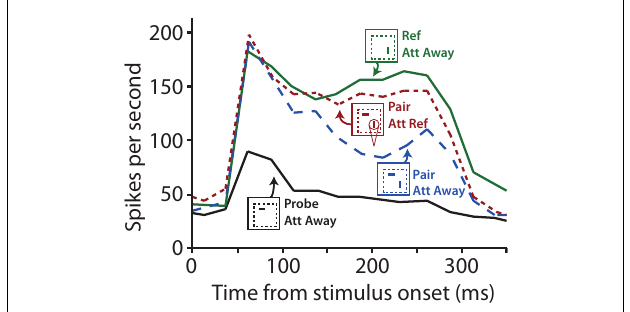
FIGURE 2 |When presented with two visual stimuli simultaneously, attention can lead to changes in firing rates that can be explained with competitive interactions between the neuronal populations coding for either stimulus. Responses of one neuron in areaV2 are plotted as a function of time (ms) after stimulus onset.The solid lines show the neuron’s response to either stimulus alone when attention is directed away (Att Away), with the black line representing the neuron’s response to the probe (horizontally oriented, non-preferred stimulus) and the green line representing the response to the reference (vertically oriented, preferred stimulus).When both stimuli are presented simultaneously (dotted lines), the neuron’s response magnitude is intermediate. Directing attention (indicated by the cone symbol) to the reference stimulus (Att Ref, in red) shifts the neuron’s response toward to reference-only response (green) compared to when attention is directed away (blue). After Figures 6A,B from Reynolds et al.